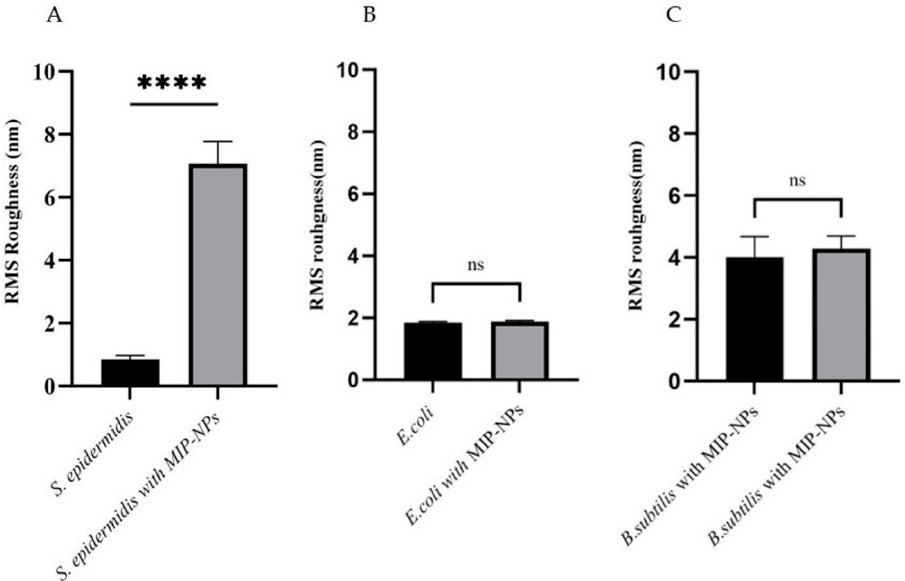
Figure 8. Analysis of the surface roughnesses (calculated based on the AFM images) of bacteria S. epidermidis ( A ) , E. coli ( B ) , and B. subtilis ( C ) in their native states (left-hand column) and incubated with 50 mg/L MIP nanoparticles, respectively, analyzed by unpaired t-test. The data represent mean ± standard deviation of roughness. **** p < 0.0001, ns = no-significant ( p > 0.005).